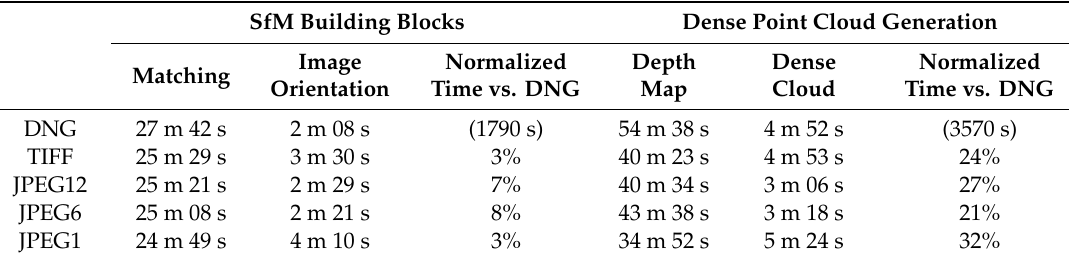
Table 15. Time processing for the experimentation on test site